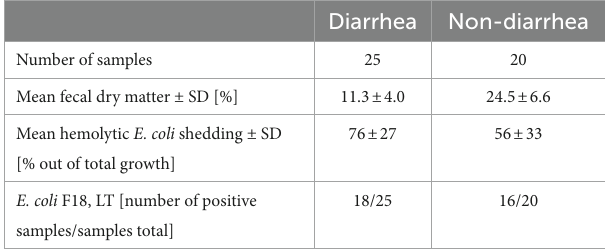
TABLE 2 Clinical microbiology and fecal dry matter characteristics of feces at PND